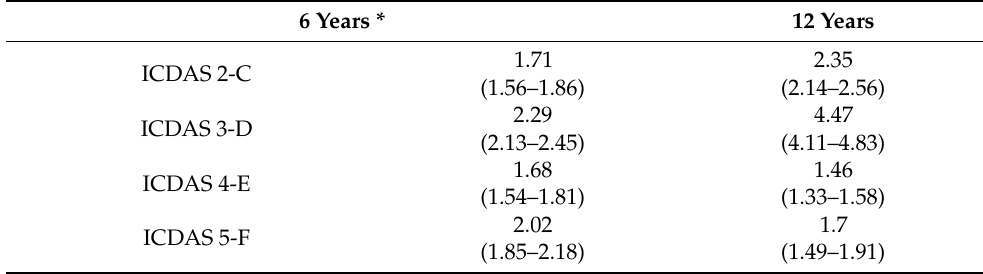
Table 1. Indicators according to teeth and age groups.